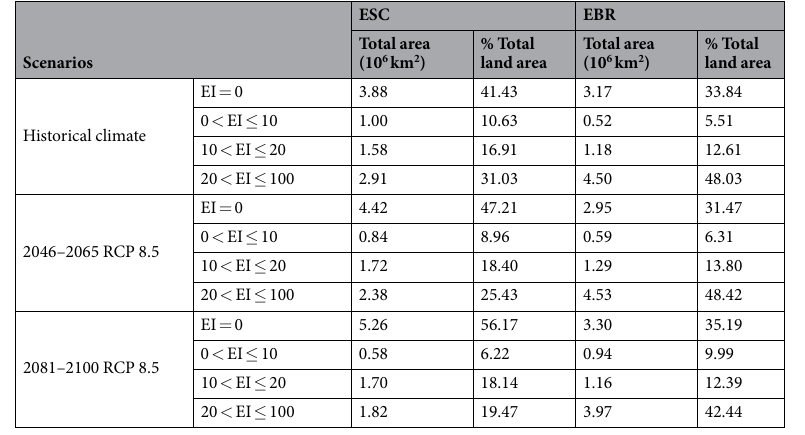
Table 2. The climatically suitable areas (EI > 0) in the United States for ESC and EBR under the historical and future climate change scenario RCP 8.5.